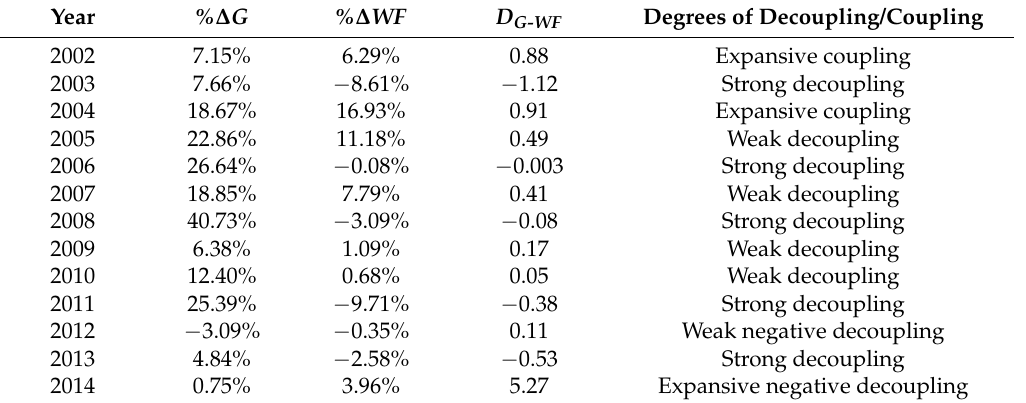
Table 4. Decoupling of WF and economic growth in China’s textile industry (2002–2014). Year % ∆ G % ∆ WF D G-WF Degrees of Decoupling/Coupling 7.15% 6.29%